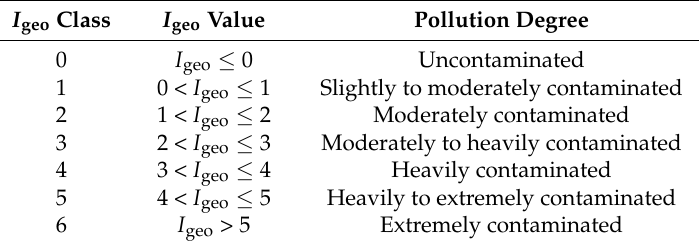
Table 1. The I geo and classification of pollution